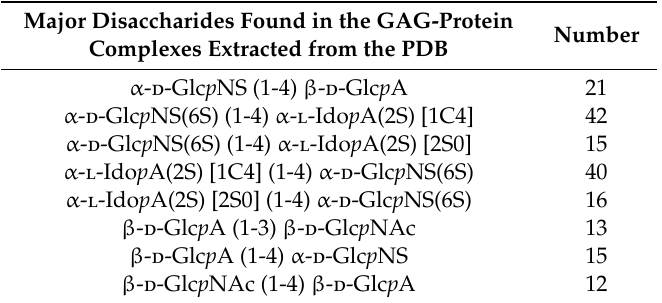
Table 1. Major disaccharides found in the GAG-protein complexes.